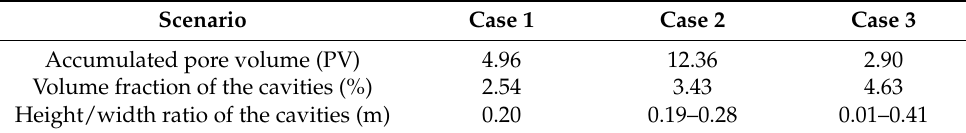
Table 2. Statistical cavity shape parameters for different heterogeneity magnitudes.